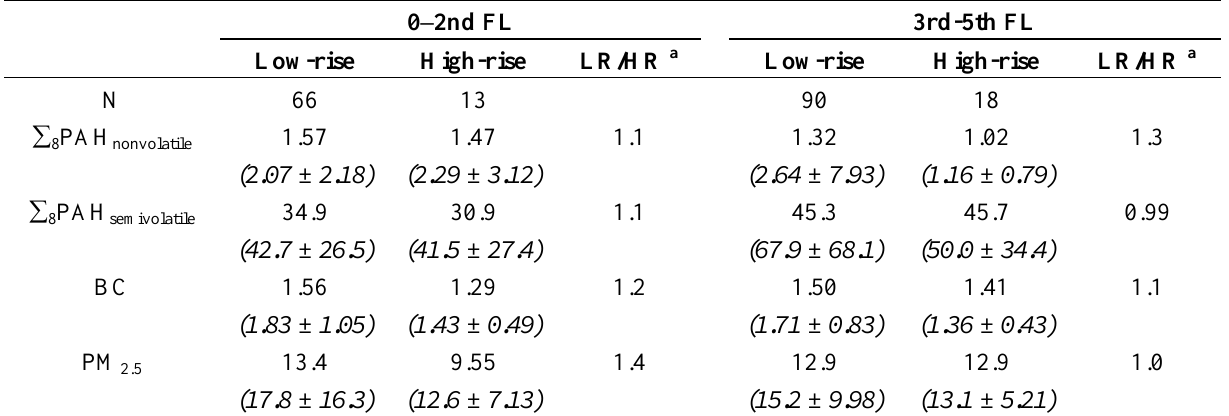
Table 3. Indoor air pollutant levels by building